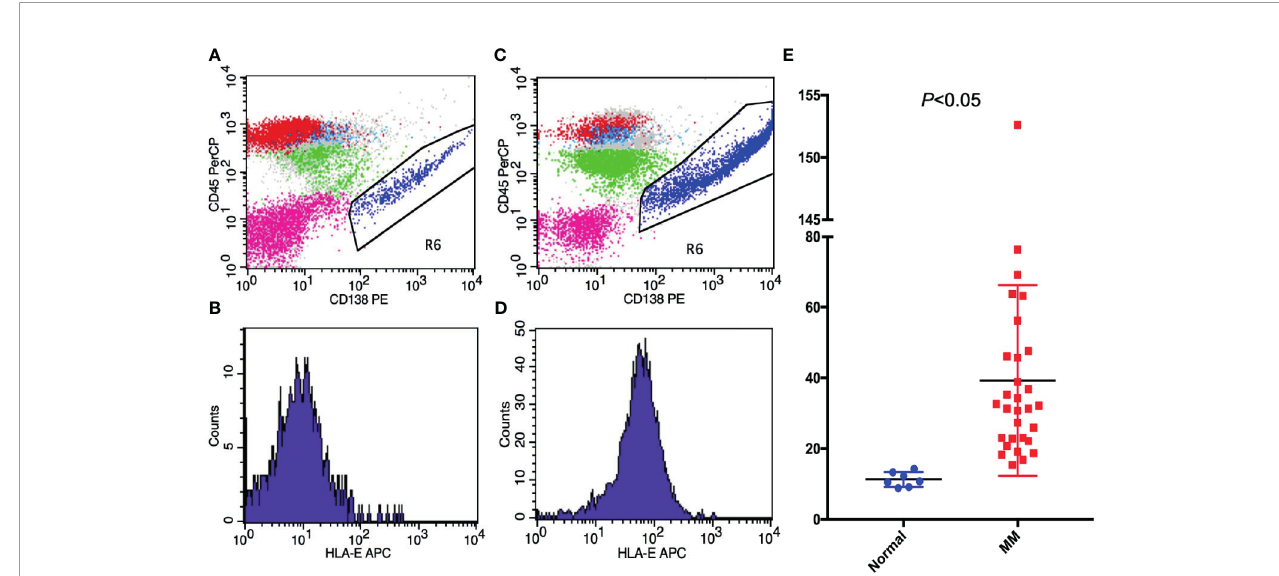
FIGURE 1 | The expressions of (A, B) HLA-E on non-malignant hematological patients; (C, D) HLA-E in MM patients; and (E) HLA-E between MM patients and non-malignant patients presented by mean fl uorescence intensity.